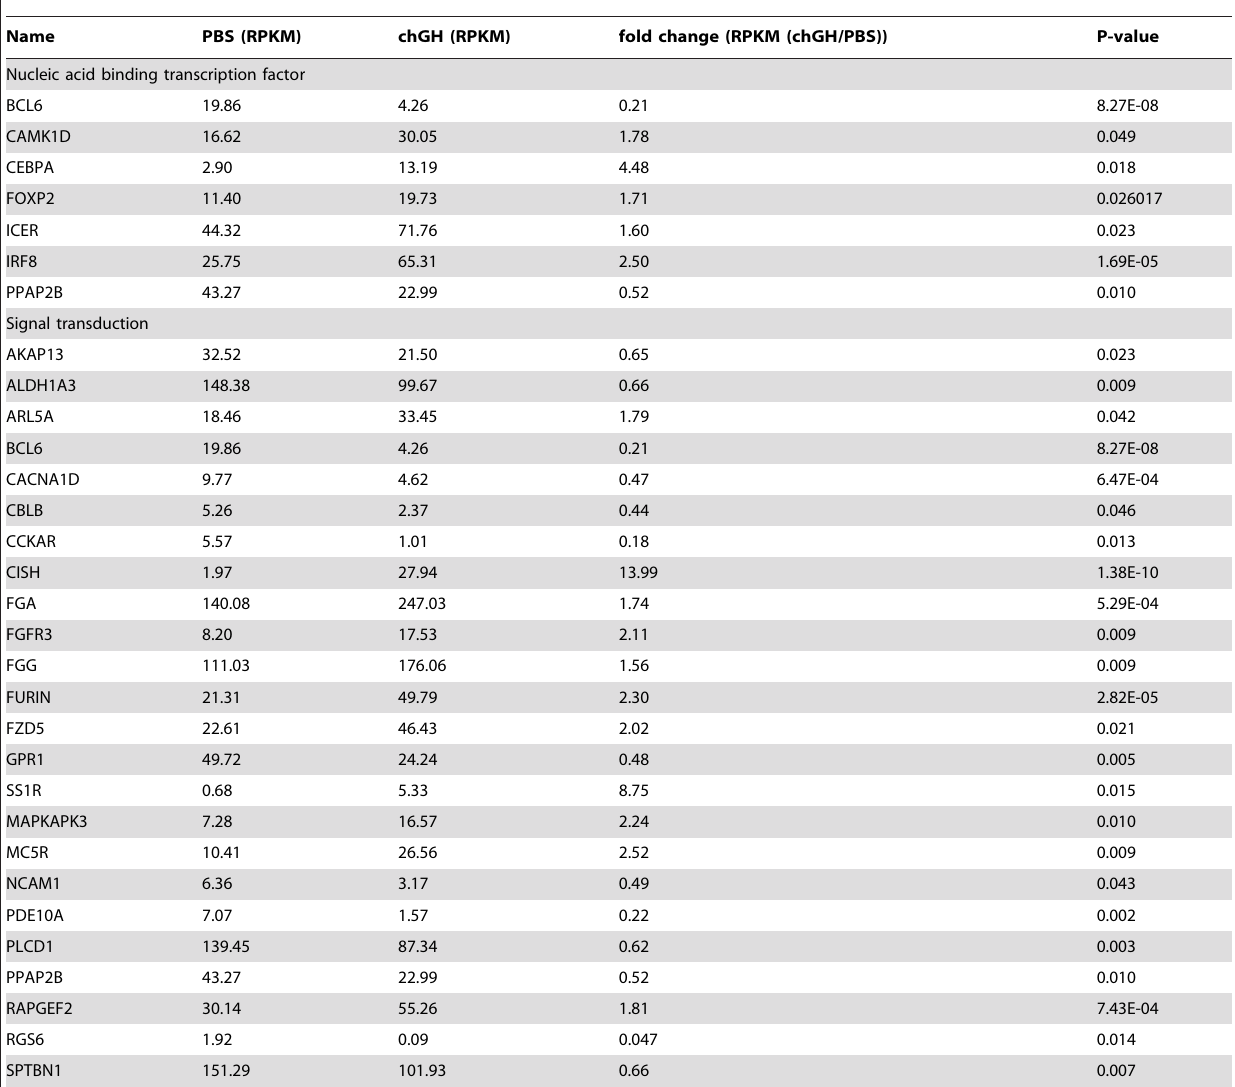
Table 6. List of signal transduction-related mRNAs whose expression in chicken hepatocytes was regulated by chGH.